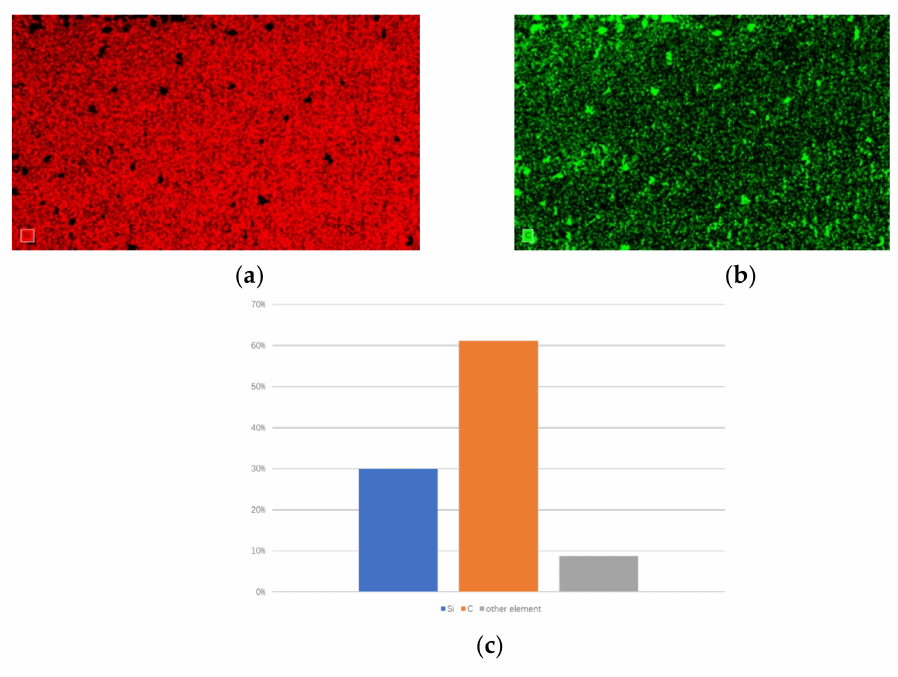
Figure 13. EDS element analysis of stripping surface. ( a )Si element distribution, ( b ) C element distribution, ( c ) atomic proportion of exfoliation